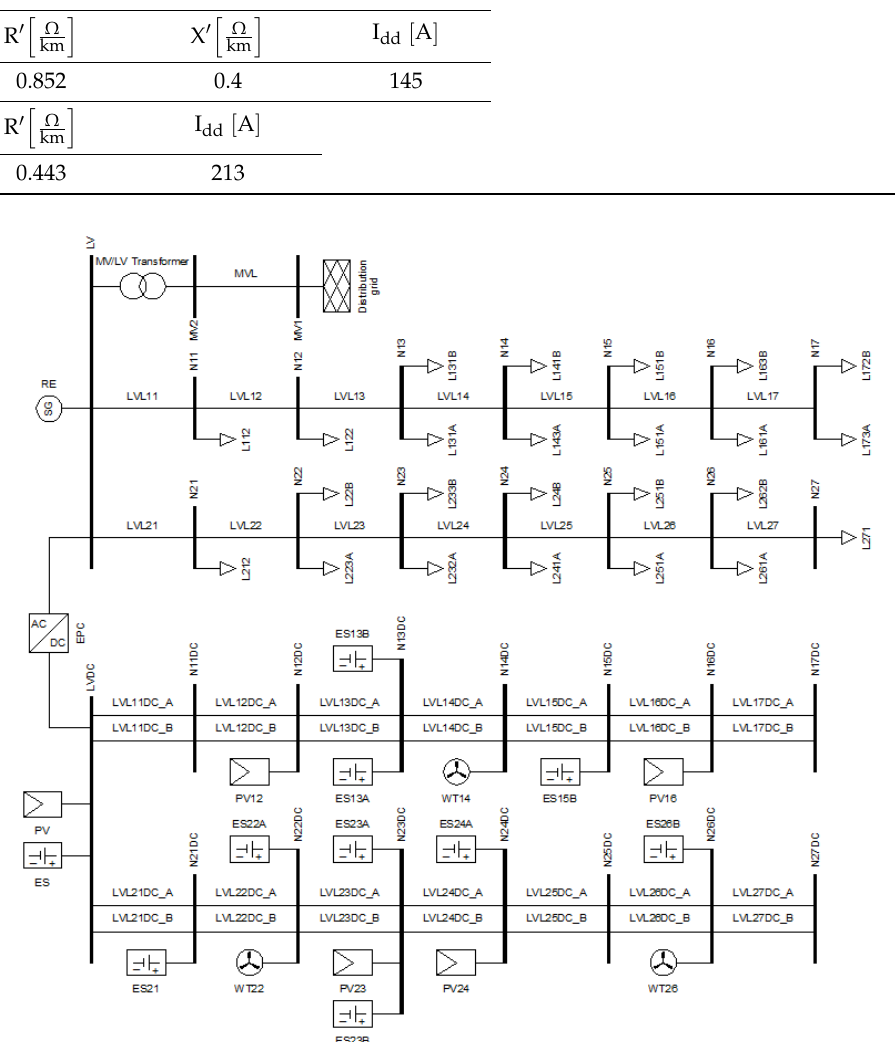
Figure 4. Schematic diagram of the test microgrid.